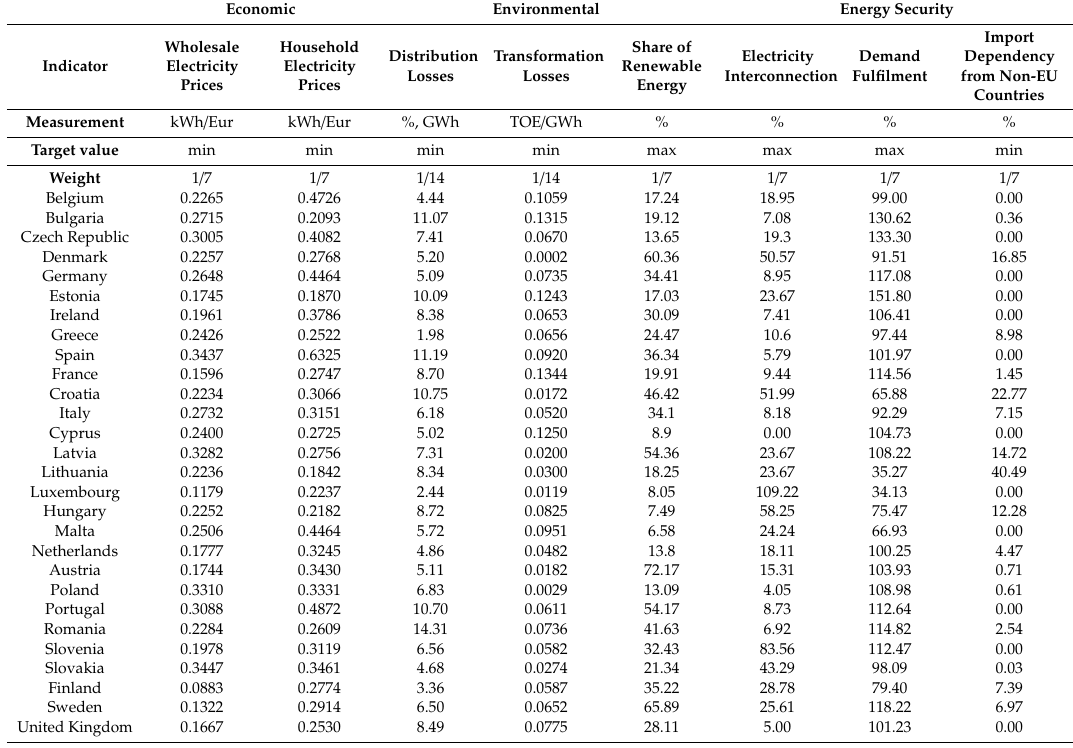
Table 4. Indicators for the assessment of sustainability of electricity sector,